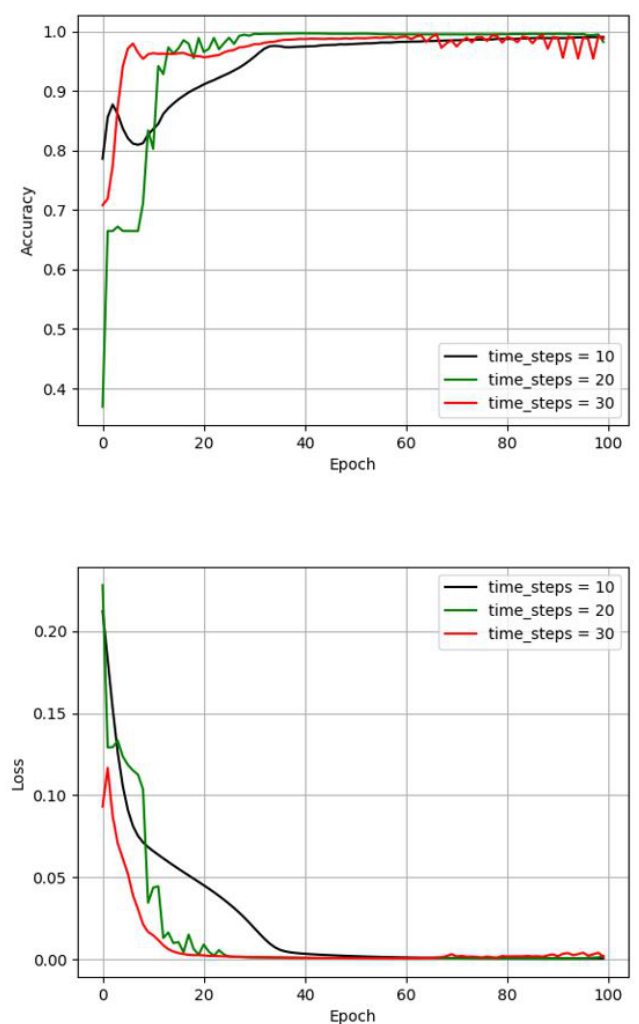
Figure 15. Localization accuracy of training data in terms of number of timesteps.